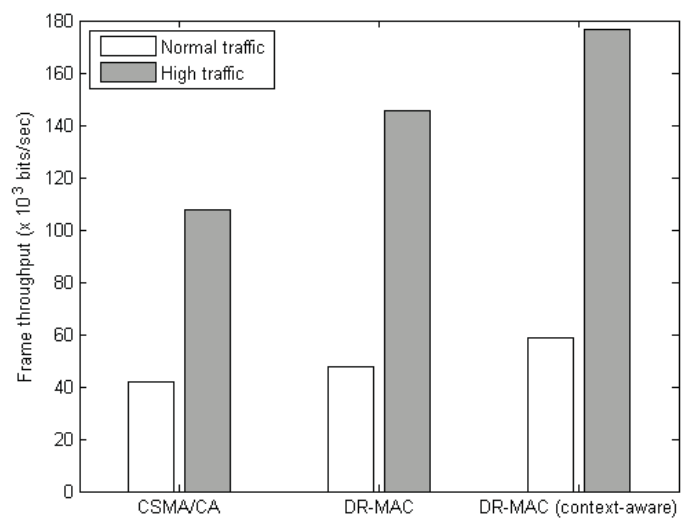
Figure 8. Frame throughput of MAC protocols.